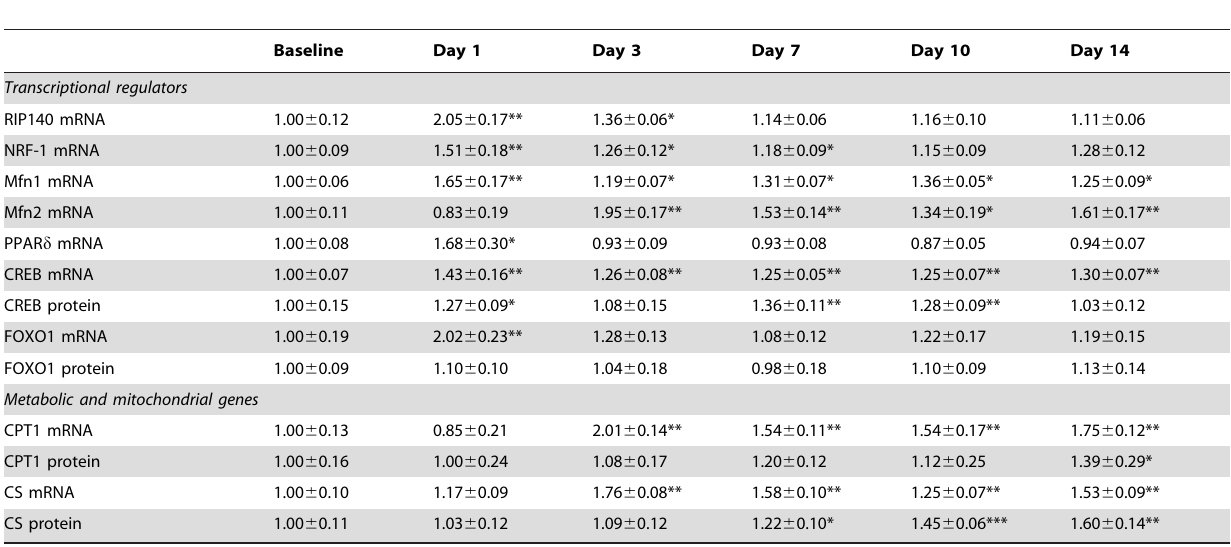
Table 1. Training-induced alterations in gene expression of selected transcriptional regulators, and metabolic and mitochondrial